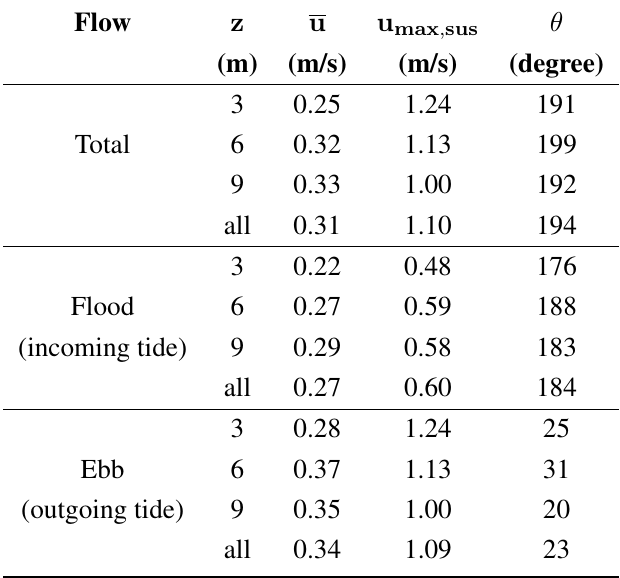
Table 4. Statistics of the total, the flood and the ebb velocity for a few of the depths bins. z = height above bottom, u = mean velocity, u and θ is the average